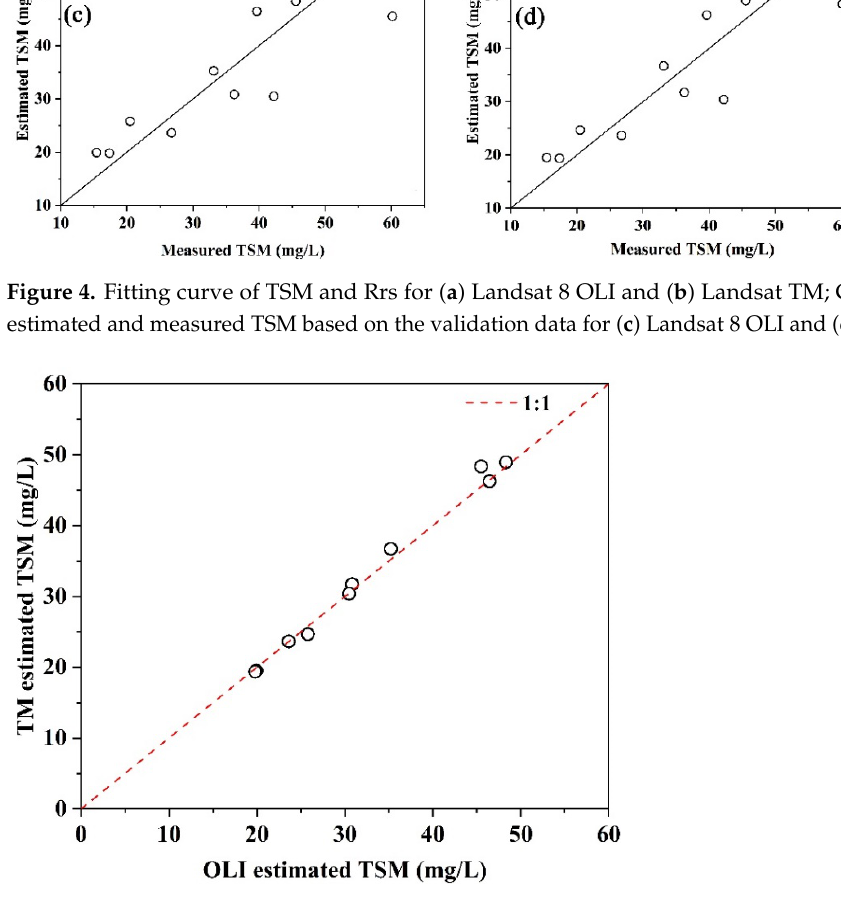
Figure 4. Fitting curve of TSM and Rrs for ( a ) Landsat 8 OLI and ( b ) Landsat TM; Comparing the esti- mated and measured TSM based on the validation data for ( c ) Landsat 8 OLI and ( d ) Landsat TM.